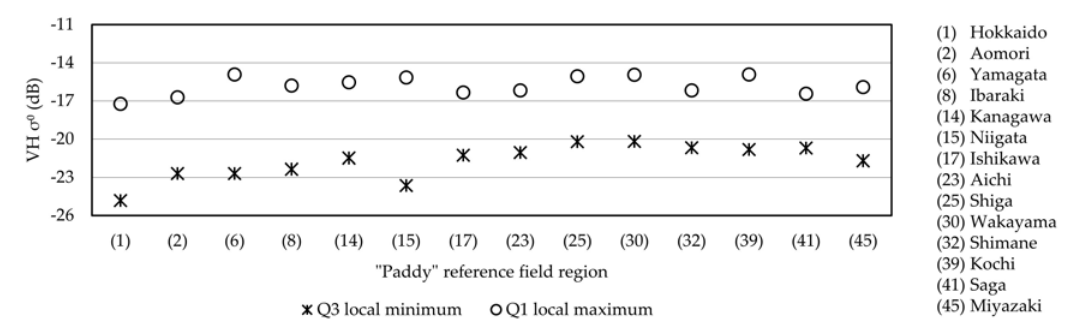
Figure 6. The local minimum Q3 value during the irrigated period and the local maximum Q1 value between the end of the irrigated period and HE in each “Paddy” reference field region.